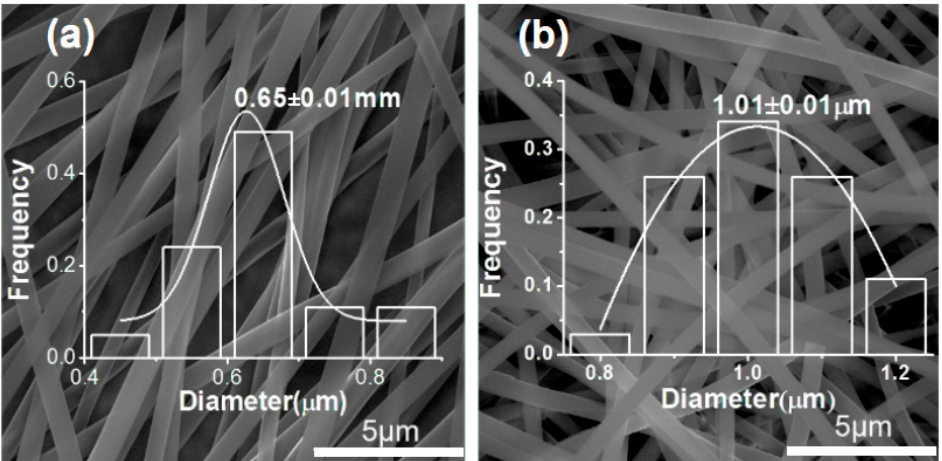
Figure 3. SEM images and diameter distribution of nanofibers with drug loading: ( a ) fibers F7 from a solution of 6% PVP and 3% IBU; ( b ) nanofibers F6 from a solution containing 9% PVP and 3% IBU. Based on the abovementioned results, nanofibers F7 were exploited to create the